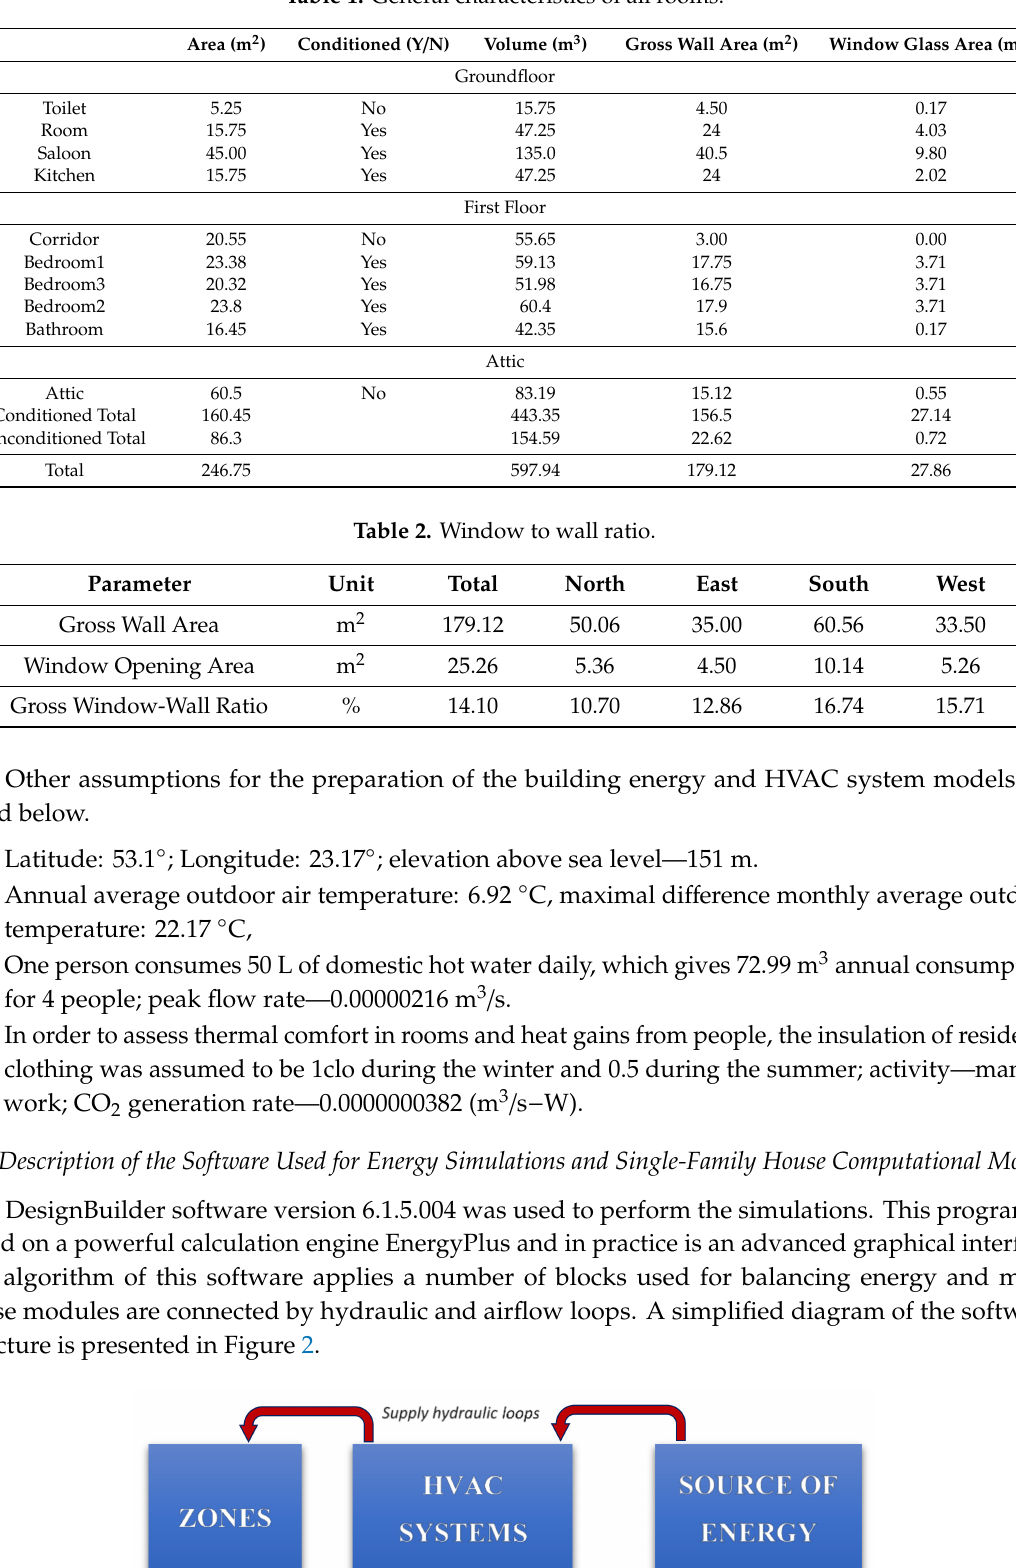
Table 1. General characteristics of all rooms.